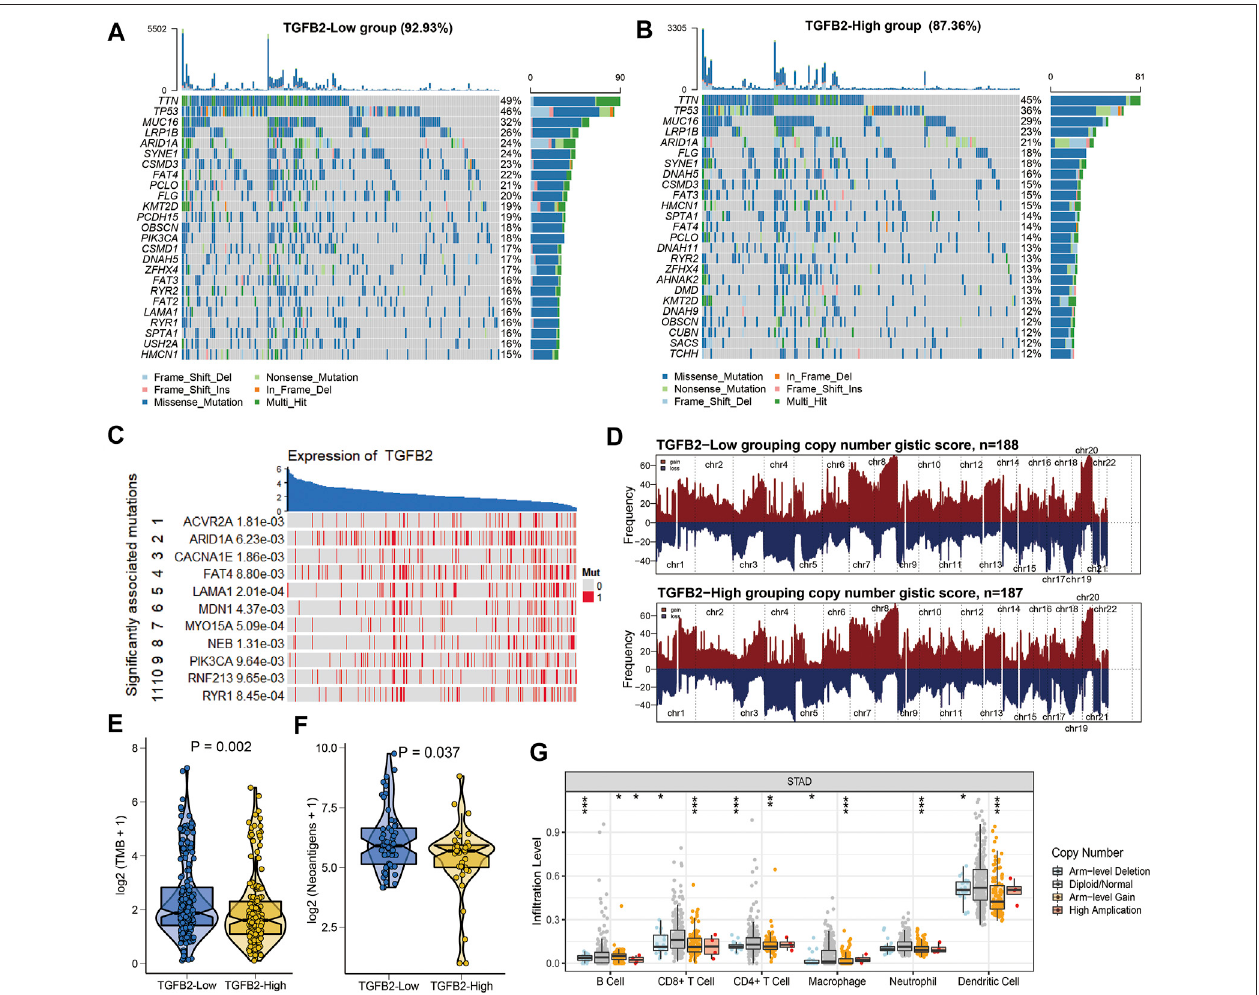
FIGURE 7 | TGF β 2 and mutations. (A, B) Waterfall plot of the 25 genes with the highest mutation frequencies in different TGF β 2 groups. (C) Mutations in genes affecting TGF β 2 expression. (D) Comparison of the frequency of copy number changes in different TGF β 2 groupings. Chromosomal locations of peaks of signi fi cantly recurring focal ampli fi cation (red) and deletions (blue) were presented. Comparison of TMB (E) and neoantigens (F) between different TGF β 2 groups. (G) Effect of the Genetic Alterations of TGF β 2 on the Immune Cell In fifi ltration. * p < 0.05, ** p < 0.01, and *** p <